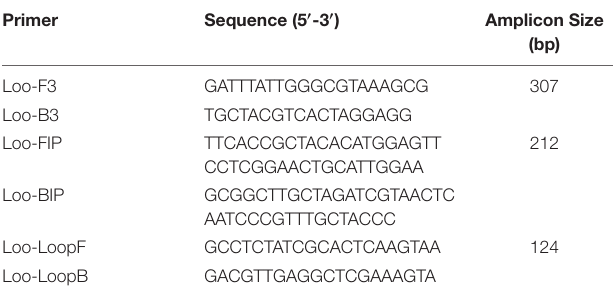
TABLE 2 | Sequences of the LAMP primer sets.